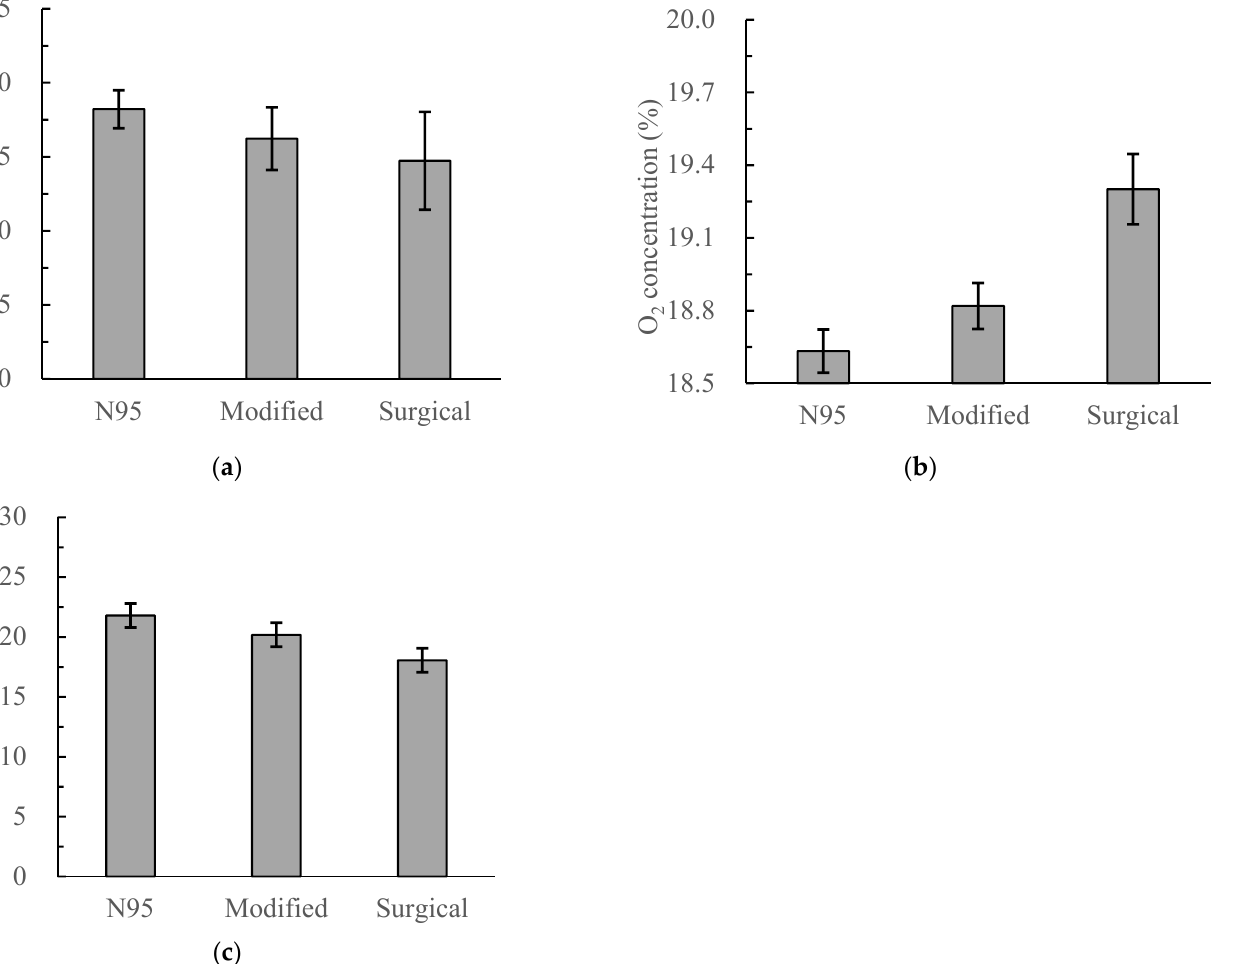
Figure 8. Concentrations of major air contents in the sampled air from three face masks: ( a ) CO 2 (background concentration: 0.05%), ( b ) O 2 (background concentration: 21.0%), and ( c ) humidity ratio (background value: 4.79 g/kg).